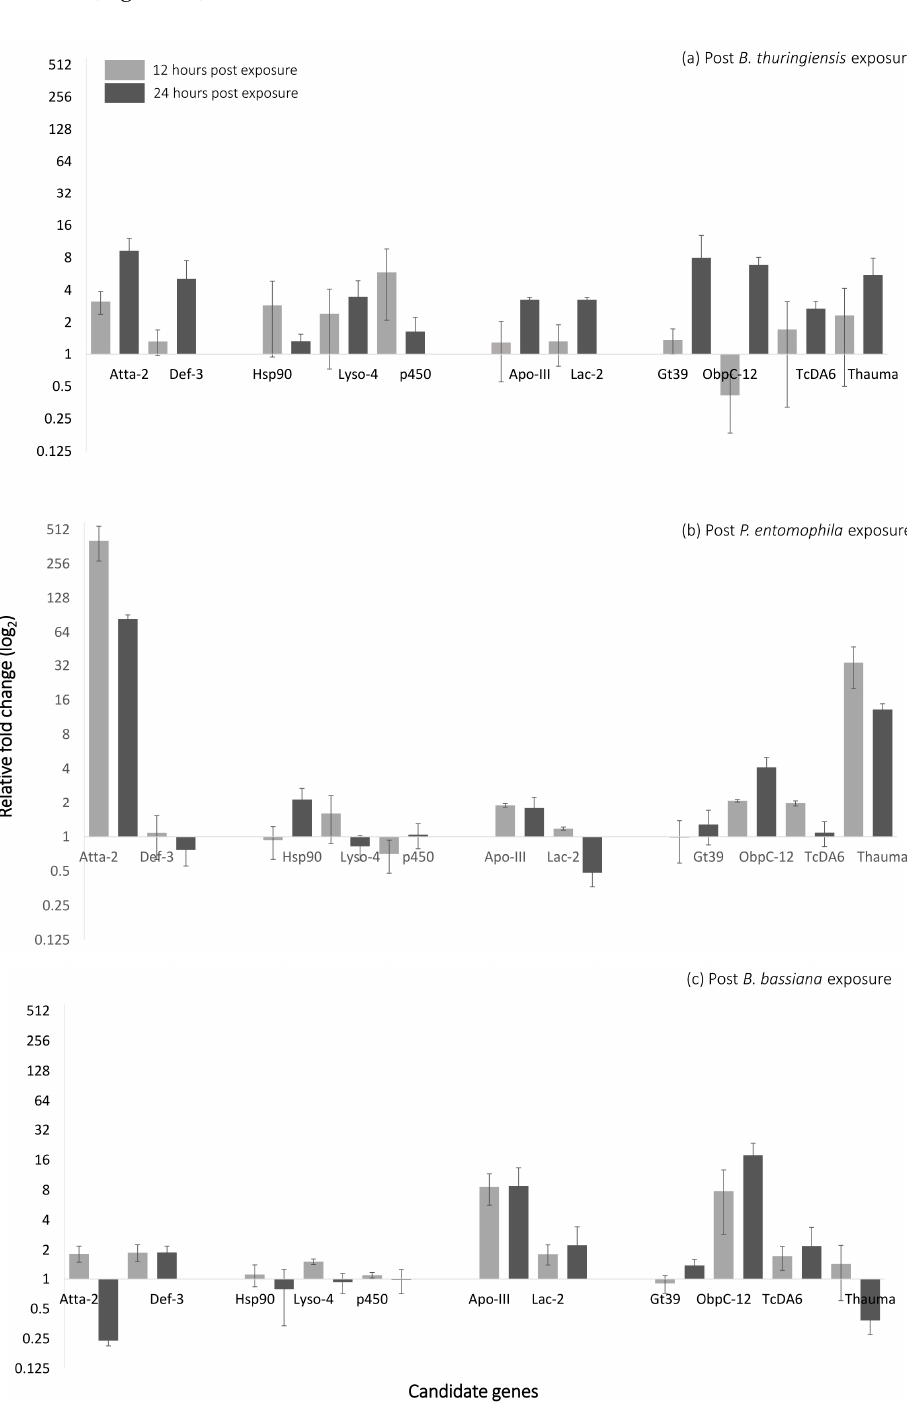
exposure as well (Figure 2c).